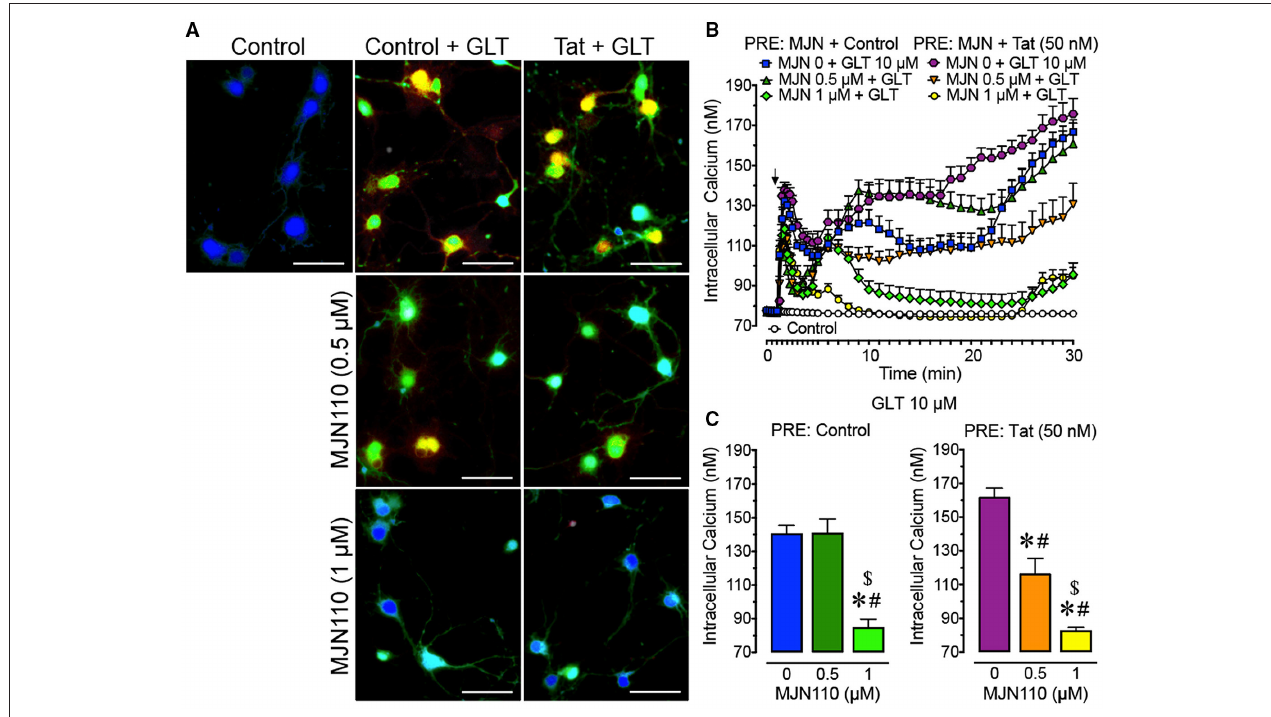
FIGURE 1 | Primary frontal cortex neuron cultures (DIV 7-11) were untreated or pre-incubated with different concentrations of MJN110 (0–1 µ M) and/or a subthreshold concentration of Tat 50nM before Ca 2 + imaging began (1h and 30min prior, respectively). (A) Pseudocolor images of neuronal ratiometric calcium imaging taken 30min after a glutamate (GLT) 10 µ M challenge (except for the control condition) with comparing frontal cortex neurons pre-incubated with vehicle solution or different concentrations of MJN110 (0.5–1 µ M) and/or a subthreshold concentration of Tat 50nM. (B) [Ca 2 + ] i levels were plotted over a 30-min time period with GLT 10 µ M being applied at the 1-min mark (arrow). Application of GLT 10 µ M onto neurons caused significant increases in [Ca 2 + ] i levels in the presence and absence of Tat and this effect was inhibited with MJN110 pretreatment in a concentration dependent manner. (C) The [Ca 2 + ] i levels are summarized for the last 10min of calcium assessment and indicate that the lower concentration of MJN110 (0.5 µ M) is more inhibitory in the presence of Tat compared to the control condition. Data are mean ± SEM. Statistical significance was determined using ANOVA and Bonferroni correction where applicable. An alpha level of p < 0.05 was considered significant for all statistical tests. * p < 0.05 vs. GLT 10 µ M (PRE: Control); # p < 0.05 vs. GLT 10 µ M (PRE: Tat 50nM); $ p < 0.05 vs. MJN110 0.5 µ M + GLT 10 µ M (PRE: Control). GLT, glutamate; PRE,